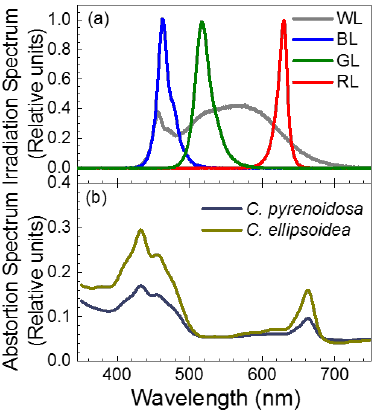
Figure 2. Irradiation spectra of di ff erent light-emitting diodes (LEDs) ( a ) and absorption spectra of the C. ellipsoidea and C. pyrenoidosa (b).